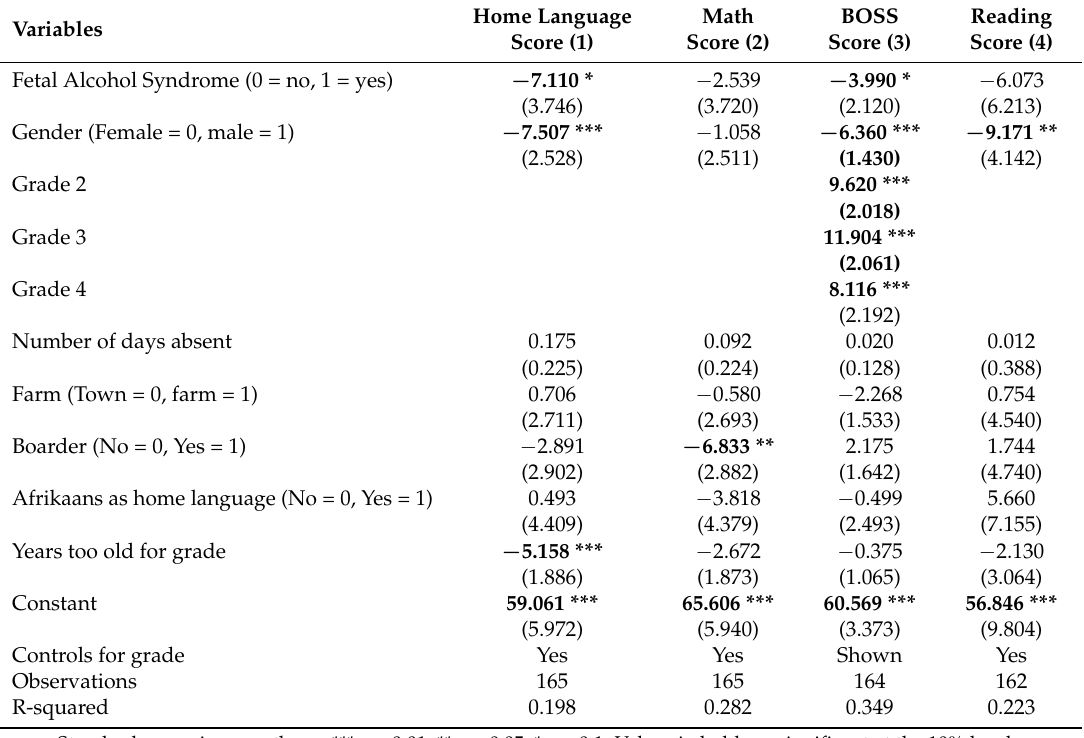
Table 2. Multiple regression analysis for educational